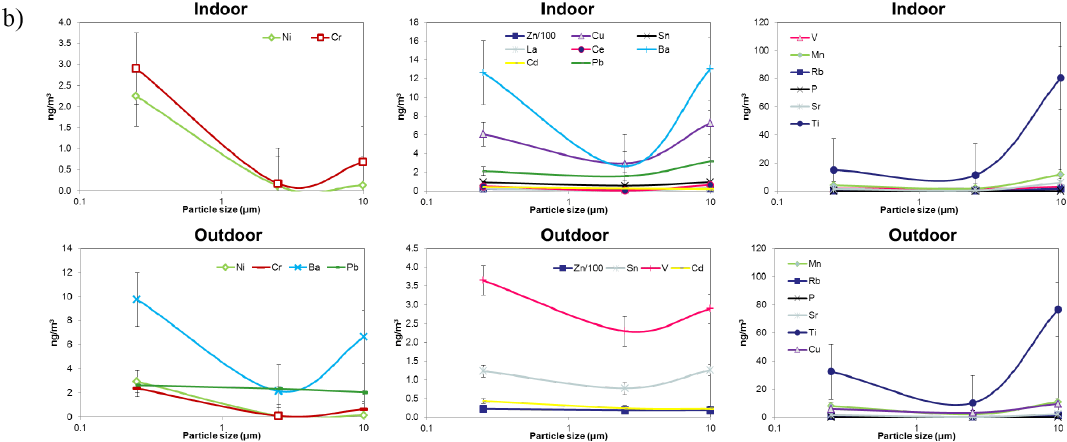
Fig. 3b. Average size distribution of trace components (including metals) in indoor and outdoor air, in terms of mass (ngm − 3 ) and including standard error